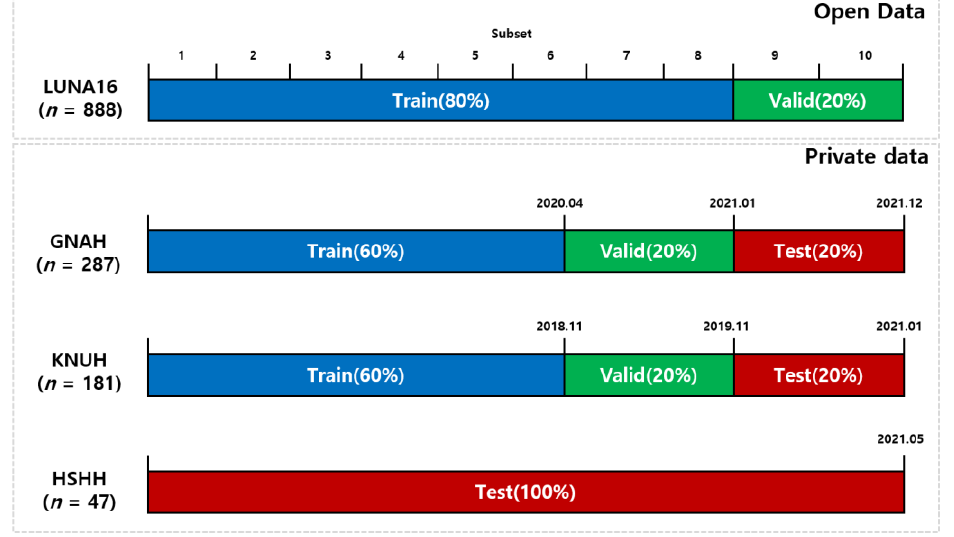
Figure 2. Illustration of dataset configuration.